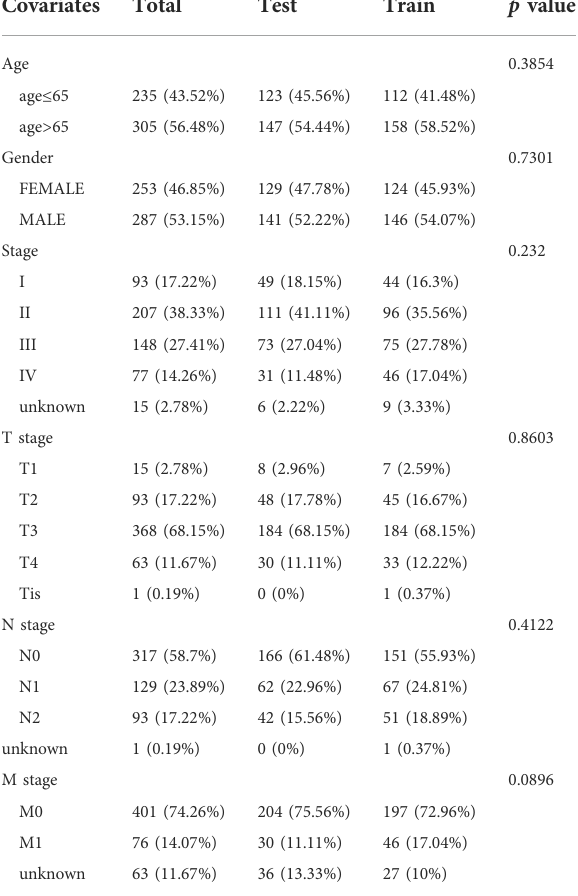
TABLE 1 Clinical information of train, test, total